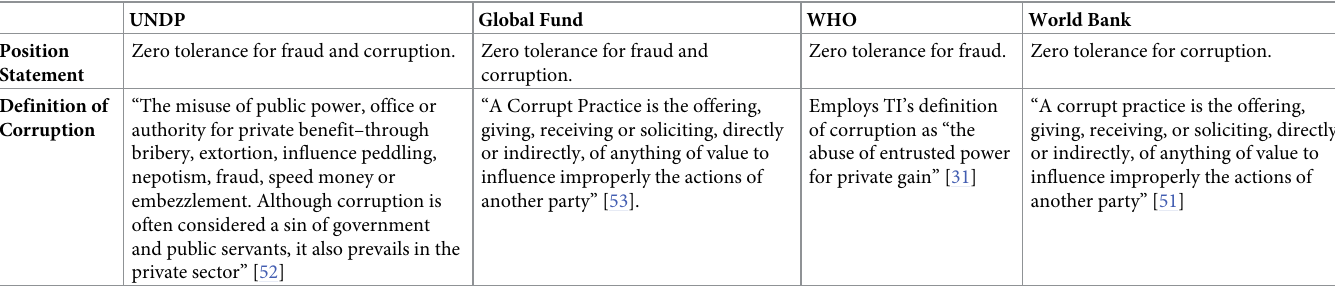
Table 2. Defining and approaching anti-corruption.